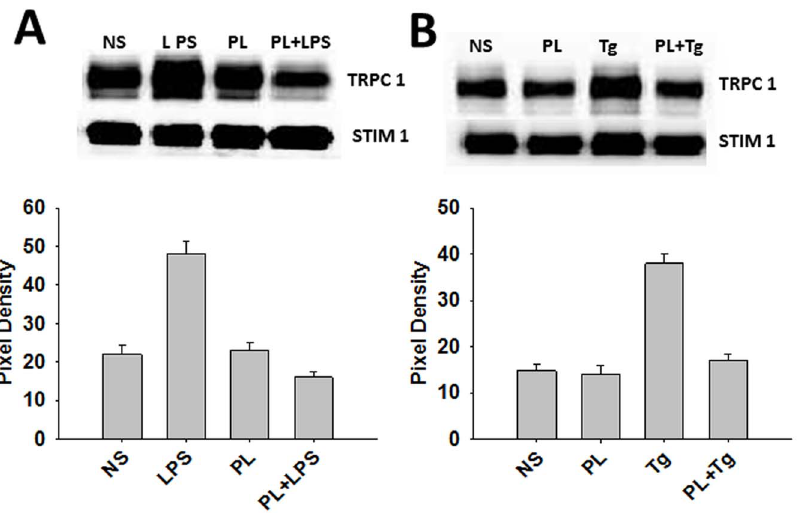
Figure 8. Helminth antigens impairment of TRPC1-STIM1 channel assembly. Co-immunoprecipitation of TRPC1 and STIM1 from BMDMs in resting, LPS-, and Tg-stimulations. A) Cells were pulsed with medium alone, PL at 25 ug/ml, LPS at 10 ng/ml, or PL before the addition of LPS to the medium. B) Cells were pulsed with medium alone, PL at 25 ug/ml, Tg at 2 m M, or PL before the addition of Tg to the medium. Immunoprecipitation of TRPC1-STIM1 complex from cell was prepared by using Anti-STIM1 Ab. Anti-TRPC1 was used for western blot detection in both Fig. 8 A and B. The average pixel intensity of the respective bands from three independent experiments was measured. This was done using the imaging software Quality One-4.6.7 (Bio-Rad).